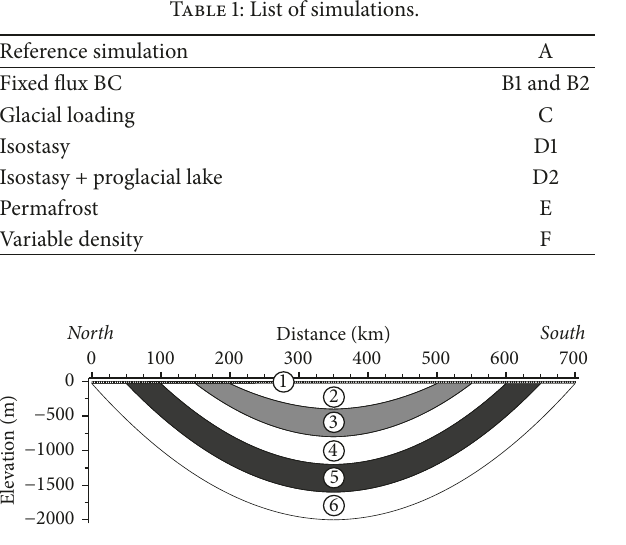
Figure 1: Conceptual basin. Circled numbers refer to hydrogeologi- cal units listed in Table 2: unit 1 = quaternary deposits; units 2, 4, and 6 = sandstone; units 3 and 5 = shale. Vertical exaggeration = 100.